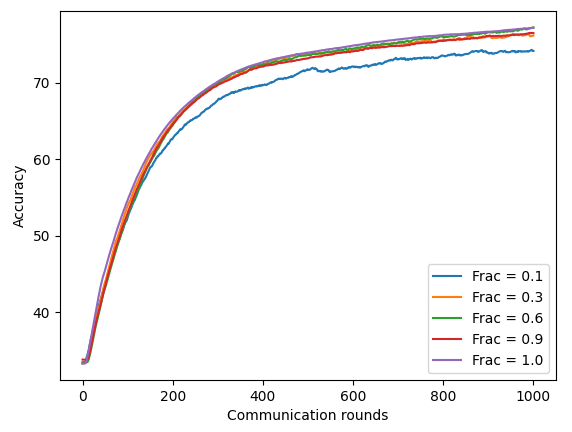
Figure 13. Non-IID with different client-fraction based on chest X-ray images.